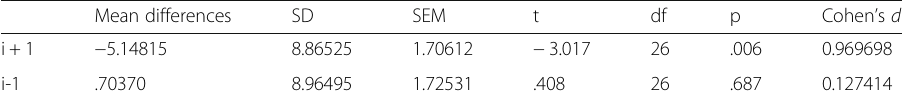
Table 10 Paired samples t-tests of both groups (MRQ before and after treatment) Mean differences SD SEM t df p Cohen ’ s d i + 1 − 5.14815